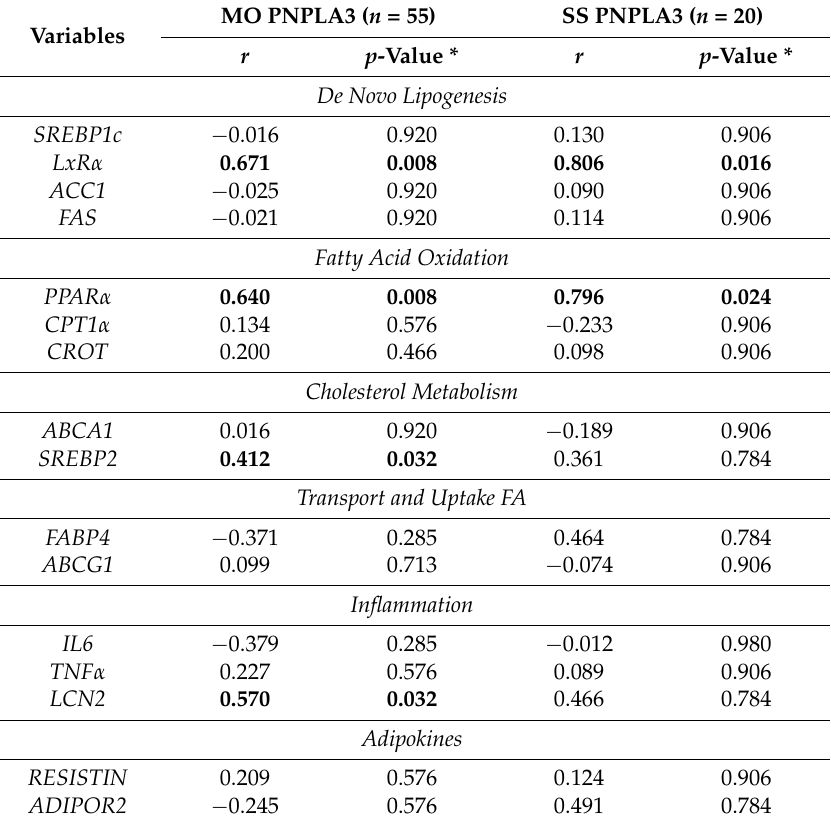
Table 2. Correlations between PNPLA3 expression and genes related to de novo lipogenesis, FA oxidation, FA transport and uptake, inflammation, adipocytokines, and cholesterol metabolism in livers from MO women and those sub-classified as SS in the MO cohort.